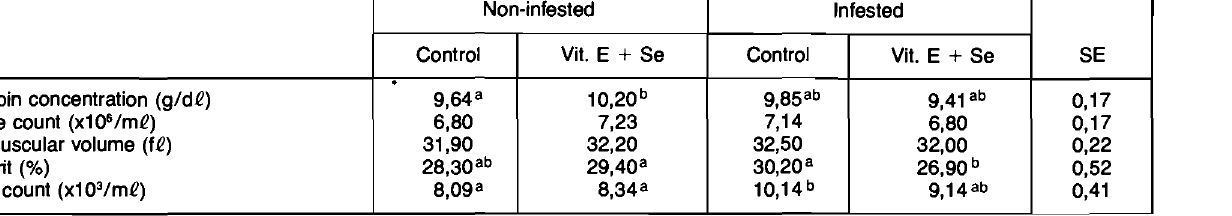
Non-infested Infested Control Vit.E+Se Control Vit.E+Se SE .